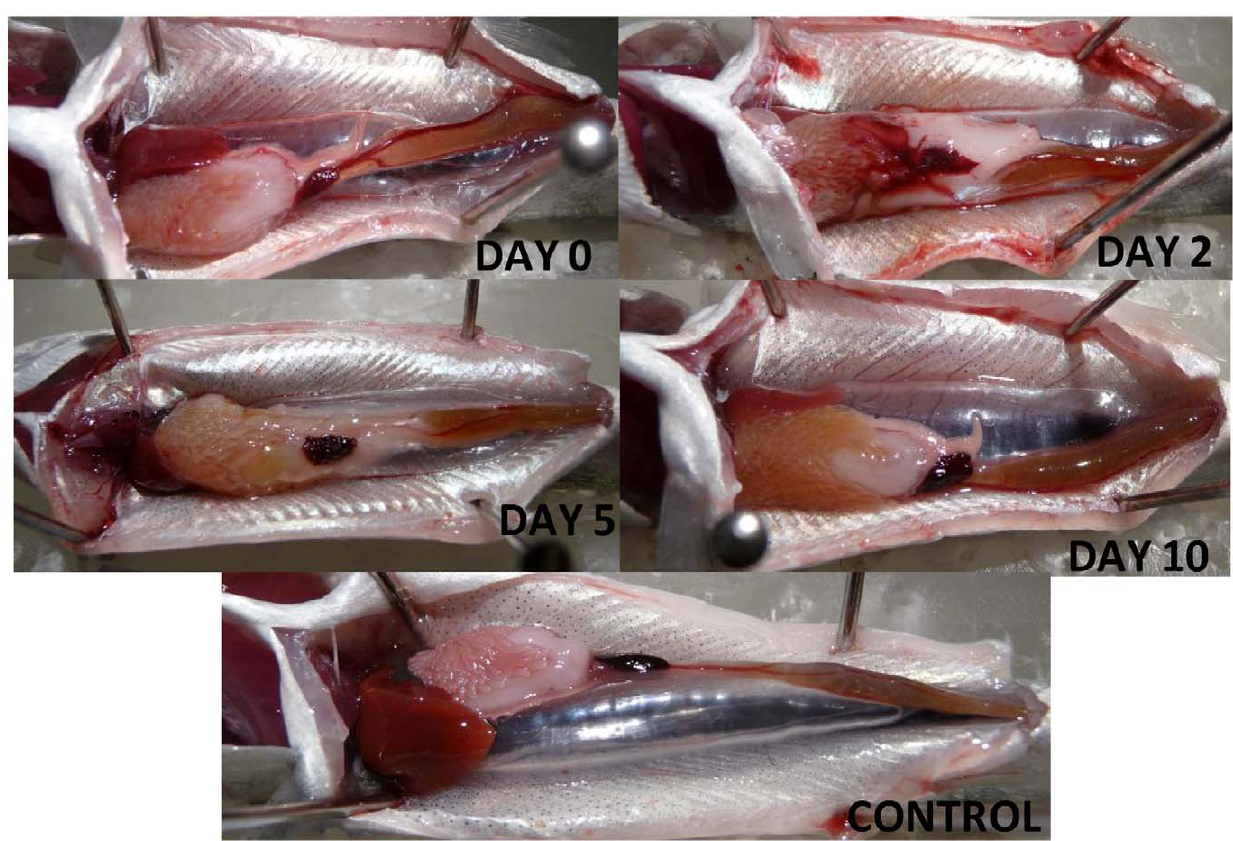
Figure 1. Photos of example injuries. Ventral view of Chinook salmon, for Exposure 1 with recovery periods of 0, 2, 5, and 10 days post-exposure as well as an example of a control fish. Day 0 displays hematomas of the swim bladder, liver, and adipose tissue, as well as hemorrhaging of the intestine. Day 2 displays hemorrhaging of the spleen and hematomas of the intestine and adipose tissue. Day 5 displays a hematoma of the intestine. Day 10 displays a fish with no visible injuries, though mottling of the spleen (raspberry appearance) can be observed which was present in most fish that were exposed to sound pile driving sounds, and not usually present in control fish. The anterior ends of all fish are orientated to the left.